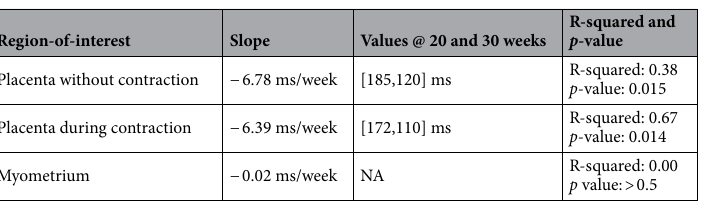
Region-of-interest